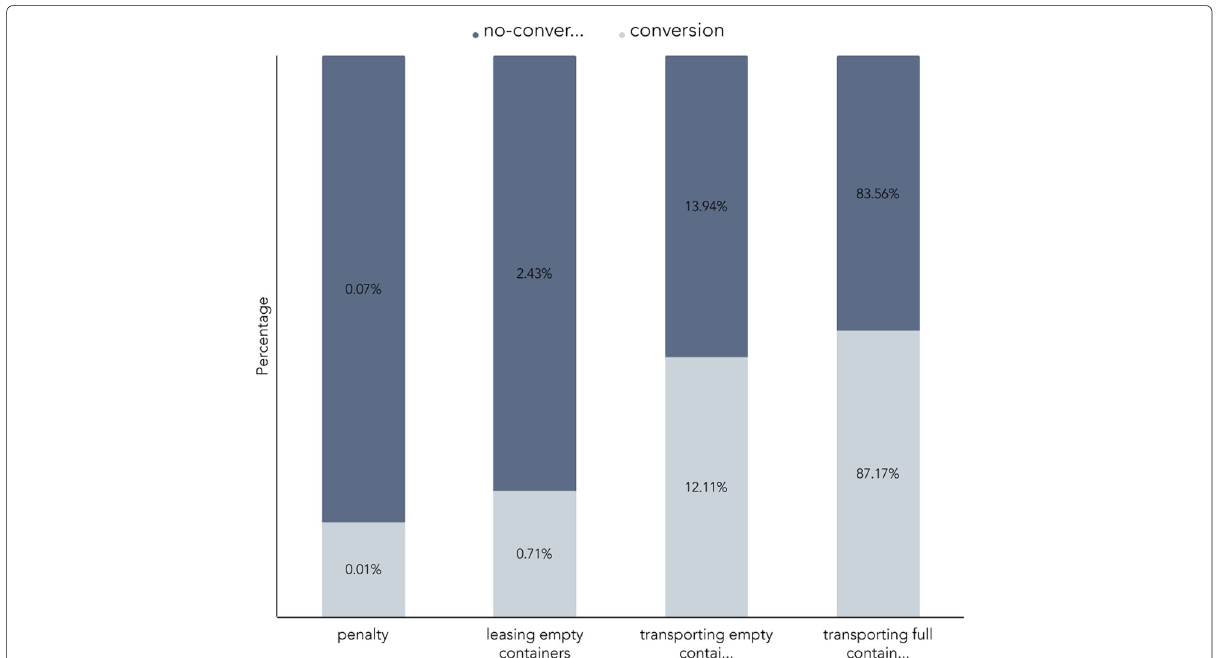
Fig. 8 Percentage of operating costs whether consider conversion of containers or not Dalian depot, but the transport costs of these leasing containers should be taken into account in operations.